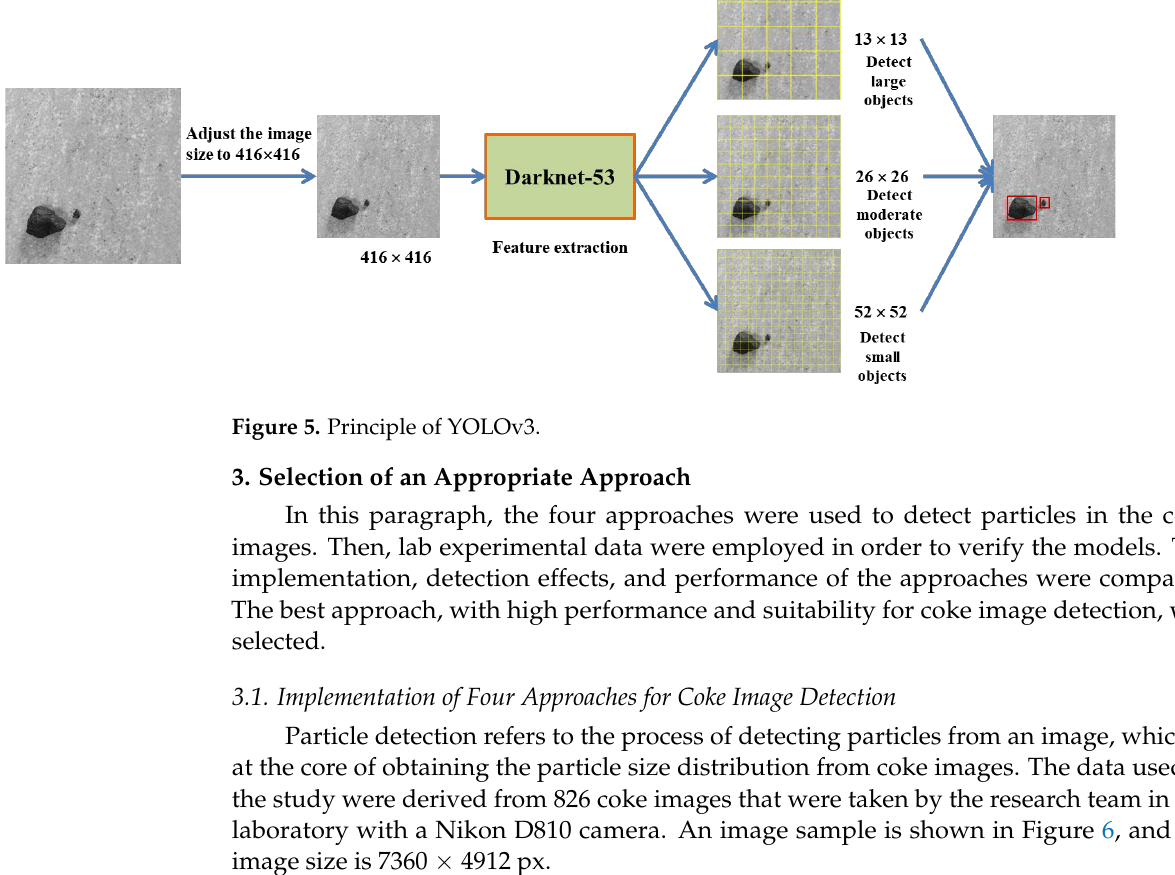
Figure 5. Principle of YOLOv3.